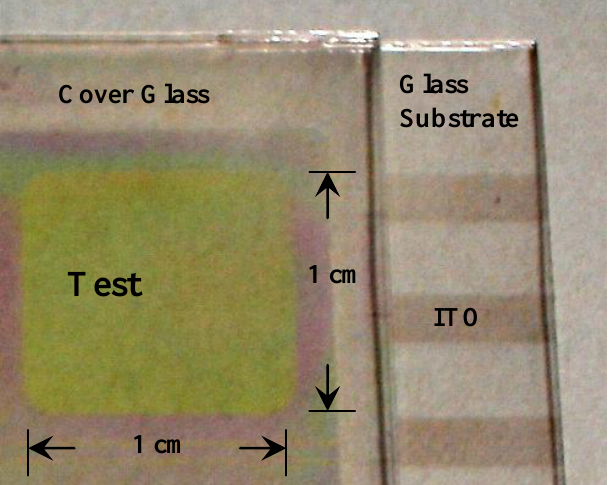
Figure 2. Top-view image of layout of LC test cell of 1 cm × 1 cm